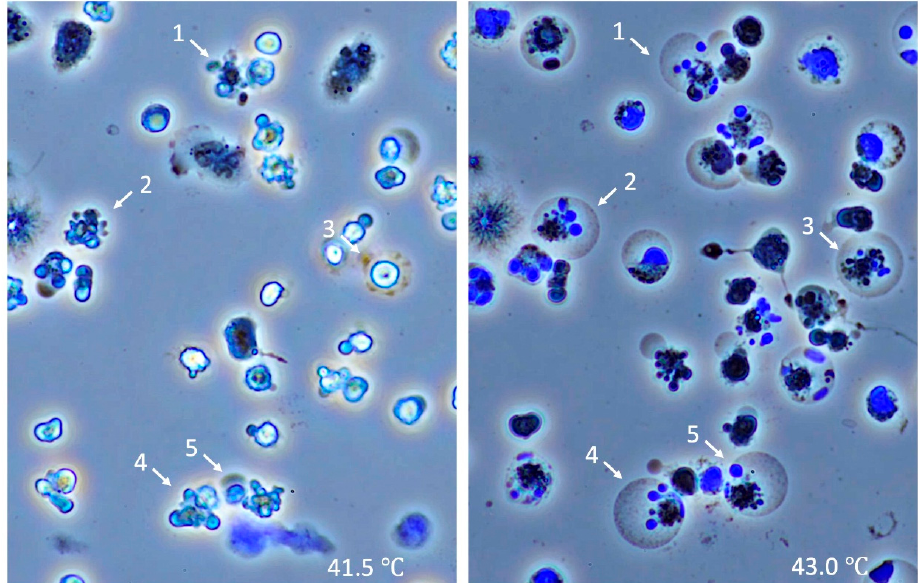
Figure 7. Time-lapse changes of leukocytes subjected to heat. Leukocytes were subjected to heat, and sequential changes were observed under the microscope with DAPI. Leukocytes began to shrink at the temperature of 41.5 °C, and some were fragmented, suggesting apoptosis was initiated at 41.5 °C ( left ). Apoptotic leukocytes started to balloon at 42.0 °C, and at 43.0 °C, most of the leukocytes died in aponecrosis ( right ). The numbers indicate identical leukocytes in different temperatures. DNA was stained blue with DAPI.